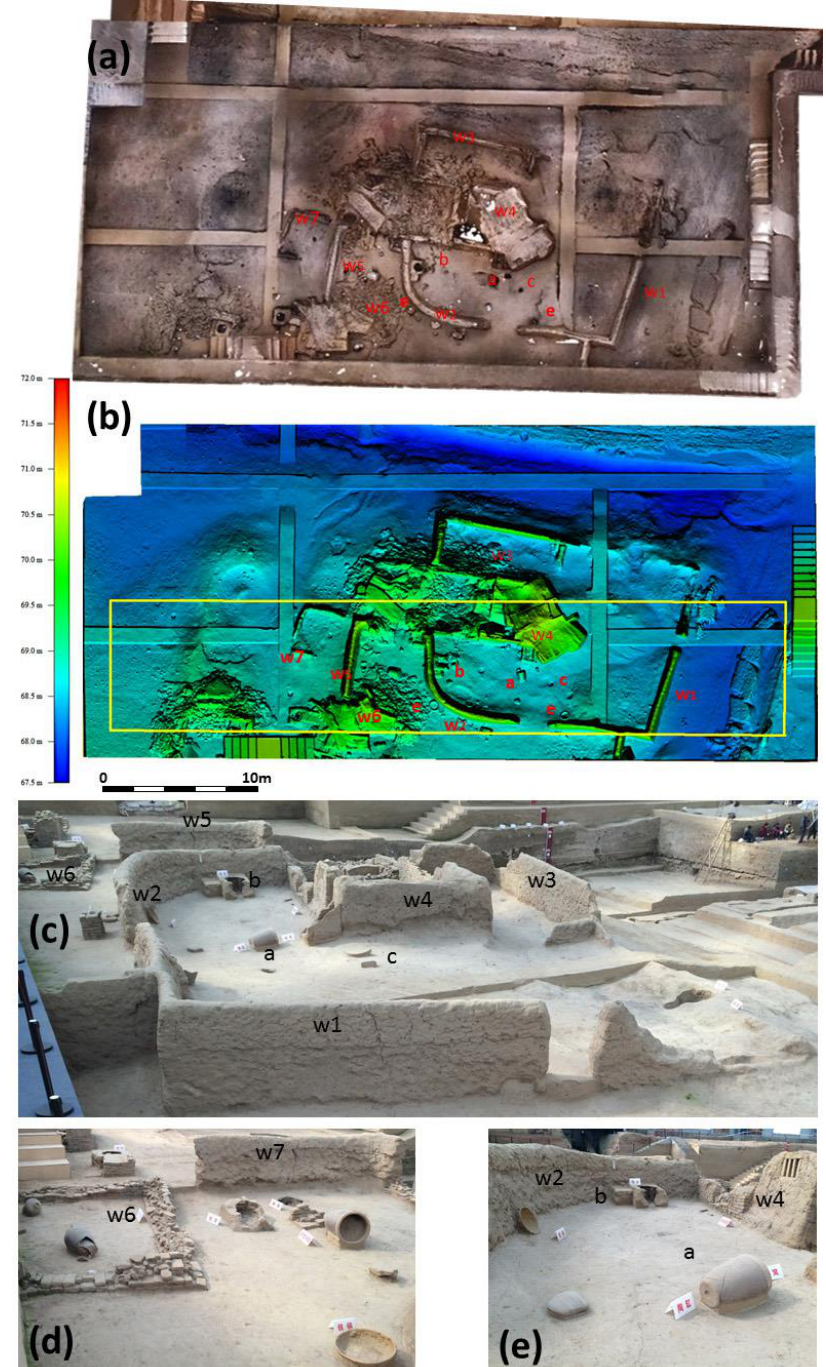
Figure 4. ( a ) orthophoto of the excavated area; ( b ) DEM; ( c - e ) details of the archaeological finding. Letters indicate some findings and remains unearthed by archaeologists: w1 to w7 are rammed earth walls, ( a ) denotes a vessel, ( b ) is an oven, ( c ) is a millstone, ( e ) is an iron vessel detected by GPR.